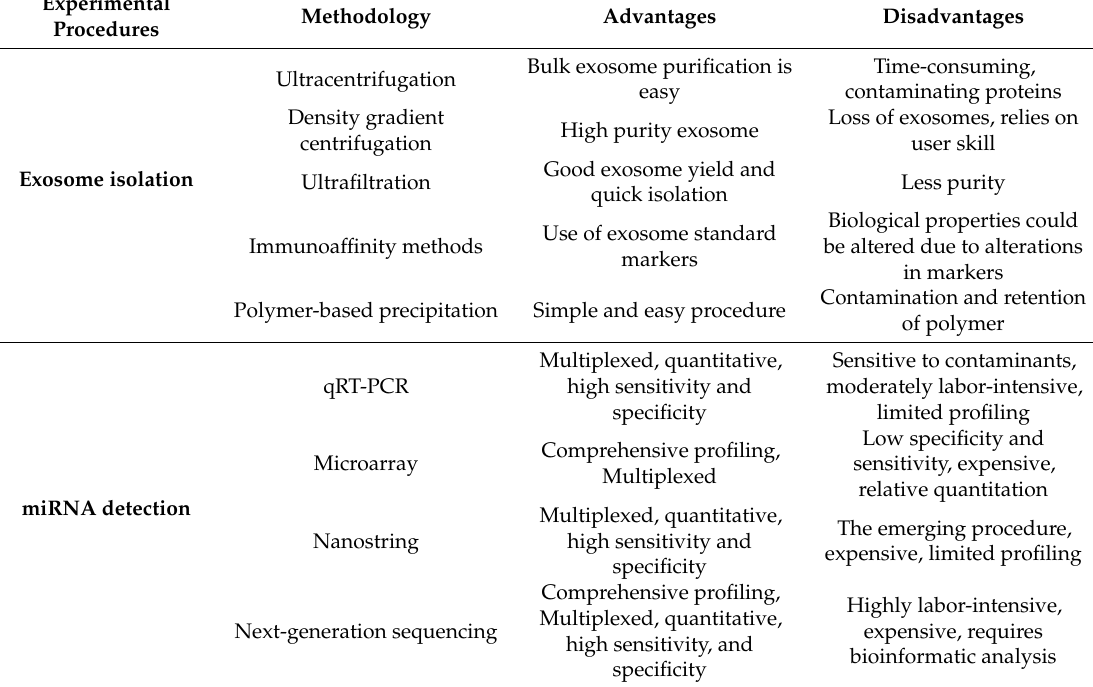
Table 1. Pros and cons of the main exosome isolation and miRNA detection methods.